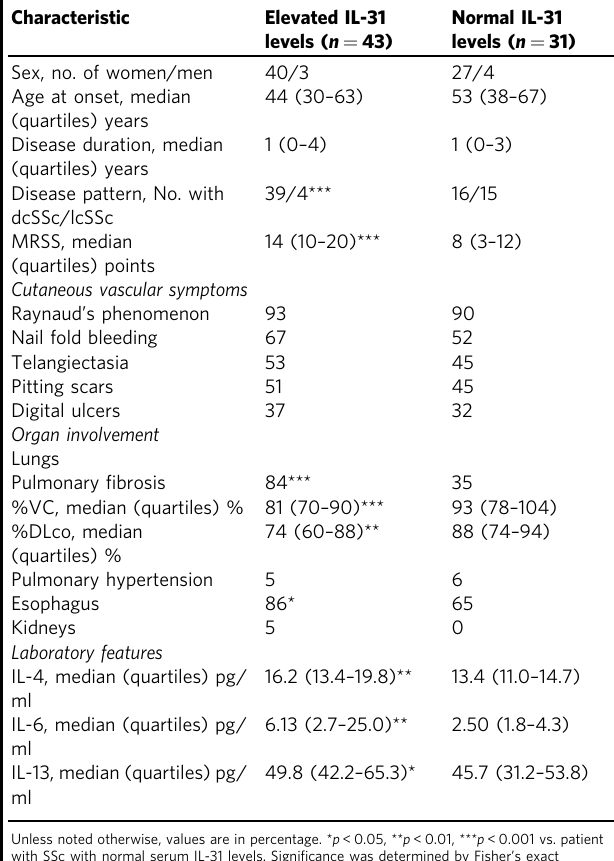
Table 1 Clinical and laboratory features of SSc